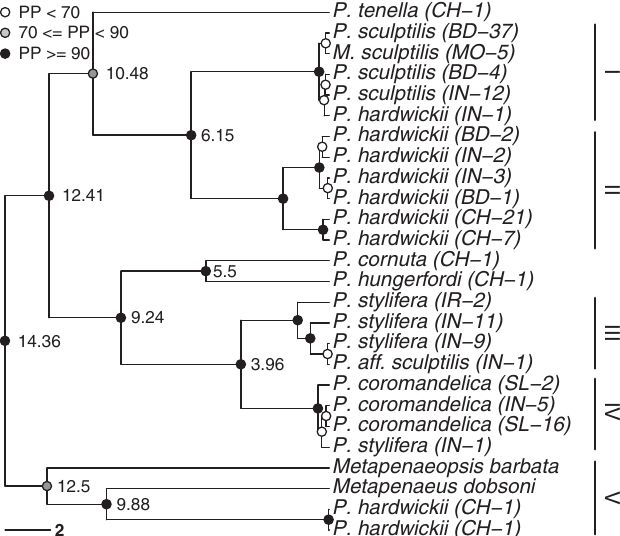
Fig. 5. Bayesian inference tree for the genus Parapenaeopsis . A 517 bp fragment of CO1 barcode for 147 sequences were utilized under ‘ GTR ’ model following a mutation rate of 1% per million year. Numbers at the nodes represent divergence in million years and shadings represent Bayesian posterior probabilities (PP,